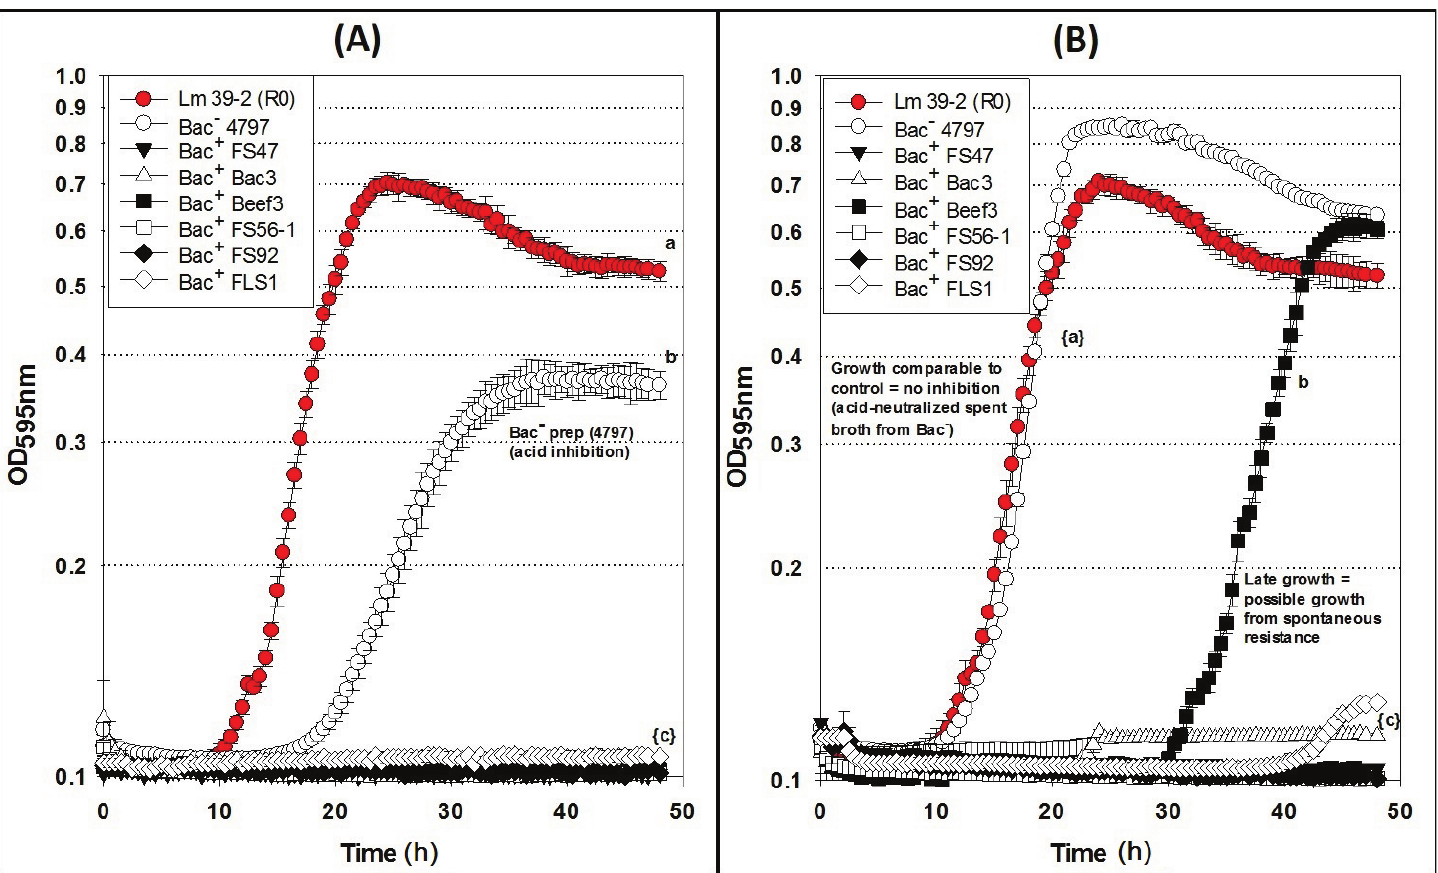
Figure 4. Microplate growth inhibition assays showing the activity of Listeria monocytogenes 39-2 (R0) treated with culture supernatants from: None (R0 Cont.), Lb. delbrueckii 4797-2 (Bac (cid:2) ), Lb. curvatus FS47, P. acidilactici Bac3, Lb. curvatus Beef3, En. faecium FS56-1, En. thailandicus FS92, and Lc. lactis FLS1. ( A ) Microplate assay using non-neutralized culture supernatants; ( B ) Microplate assay using neutralized culture supernatants. Data points represent the means of triplicate replications and error bars represent the standard deviations from the means (error bars were not used for all curves in order to prevent clutter). Treatments with different lowercase letters are significantly different ( p < 0.05); letters in brackets are for entire group of graph